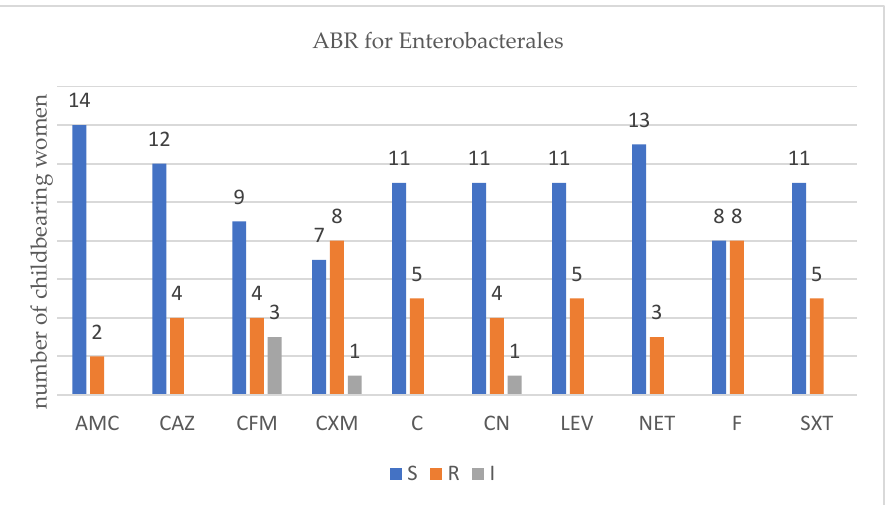
Figure 1. Profile of antibiotic resistance for Enterobactales; S = sensitive, I = intermediate; R = resistant. Legend: amoxicillin/clavulanic acid (AMC), ceftazidime (CAZ), cefixime (CFM), cefuroxime (CXM), chloramphenicol (C), gentamycin (CN), levofloxacin (LEV), netilmicin (NET), nitrofurantoin (F), and trimethoprim-sulfamethoxazole (SXT).